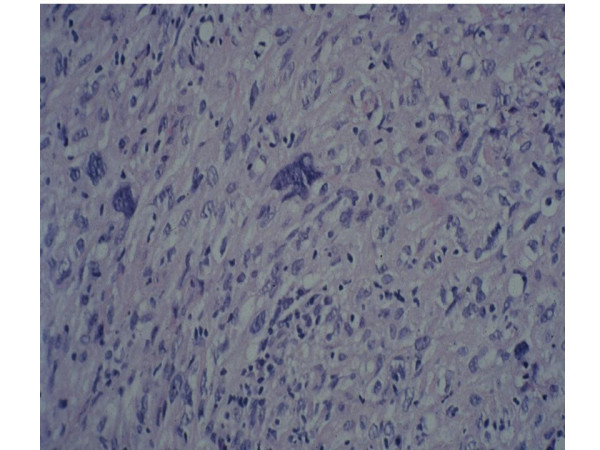
Malignant pleural mesothelioma of sarcomatous type. Sarcomatous MPM originates from the deep connective tissue of the mesothelial surface and resembles fibrosarcoma. (Personal photo of Neragi-Mianoab).